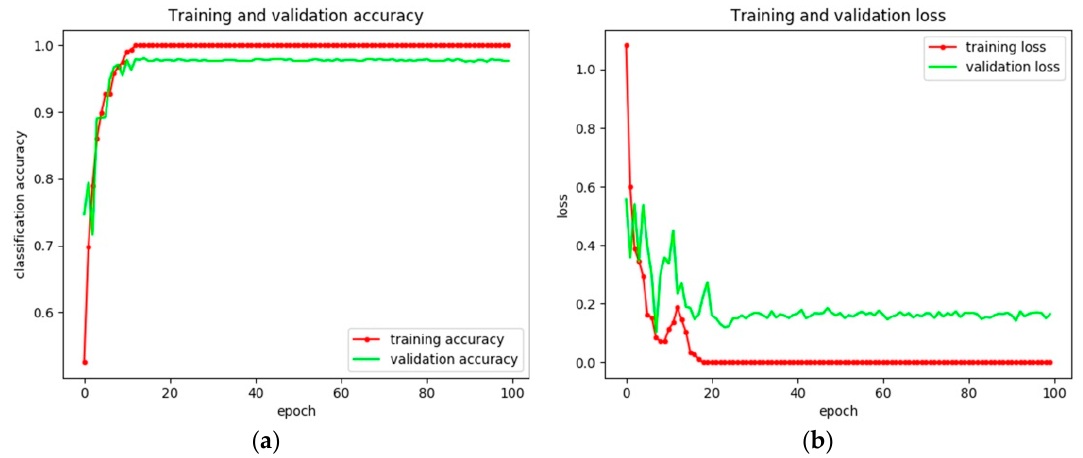
Figure 9. Experimental results of the ship classification model based on VGG16 via fine tuning. ( a ) Training and validation accuracy and ( b ) training and validation loss.